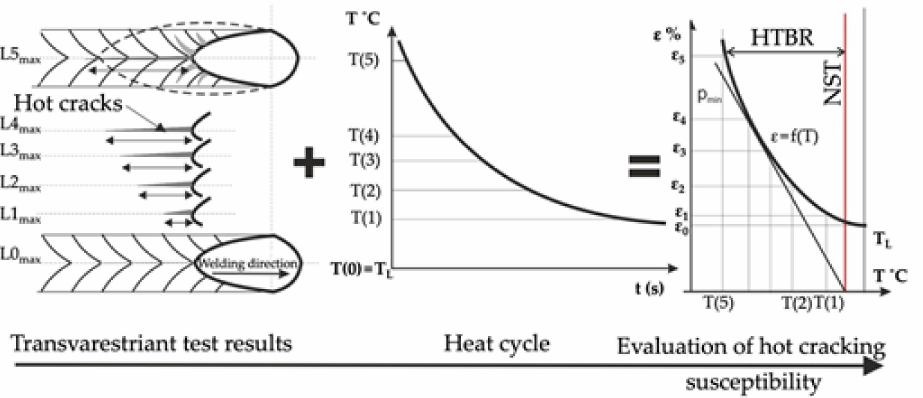
Figure 8. Methodology for determining the HTBR based on the results of the transvarestraint